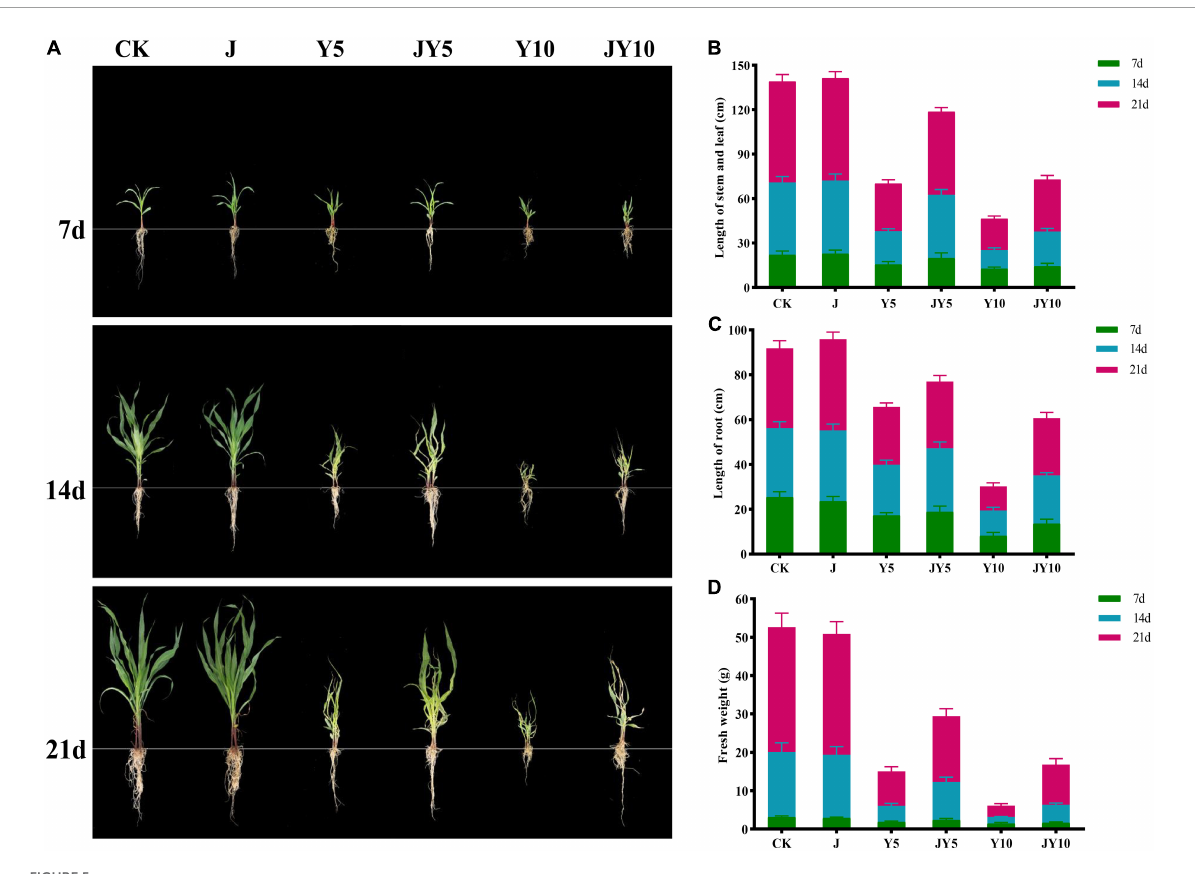
FIGURE5 Effects of lactofen and solid agents on physiological indices of maize. (A) Growth status of maize under each treatment; (B) Length of stem and leaf (cm); (C) Length of root (cm); (D) Fresh weight (g). CK, control; J, solid agents; Y5, 5 mg/kg lactofen; JY5, 5 mg/kg lactofen + solid